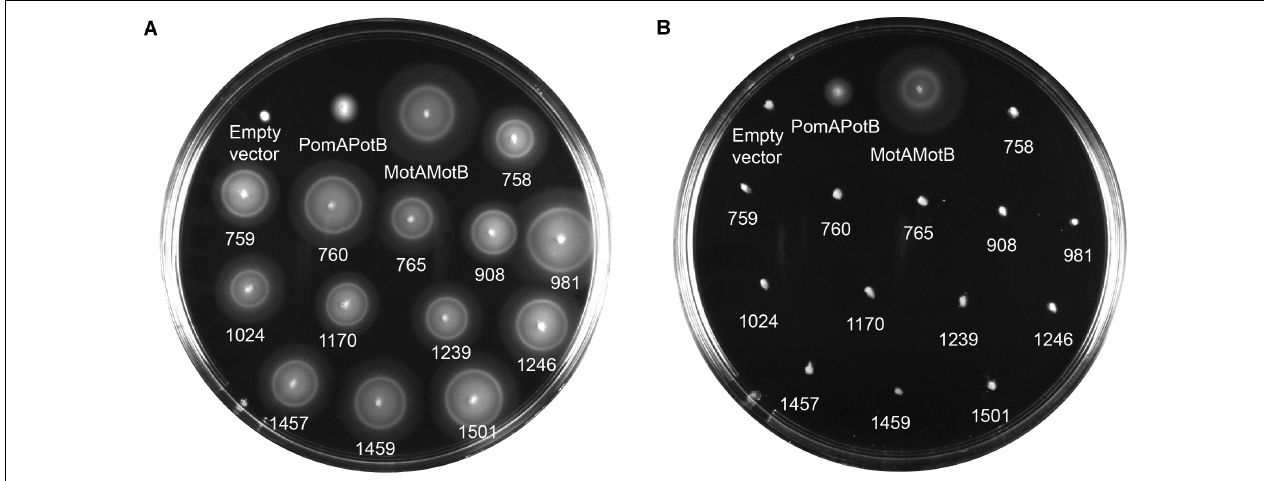
FIGURE 3 | MotB-ASRs are functional. Motility of resurrected MotB-ASRs along with the control Na + swimmer (PomAPotB), H + swimmer (MotAMotB), and non-swimmer (empty vector: pBAD33) were tested on semi-solid agar swim plates (0.25% w/v agar). (A) All MotB-ASRs (presented according to the respective nodes) restore motility in the presence of PomA (from plasmid) and MotA (from genome) in (cid:49) motB E. coli strain RP3087. (B) None of the resurrected MotB-ASRs restore motility in presence of PomA without MotA in (cid:49) motAmotB E. coli strain RP6894. Plates were incubated at 30 ◦ C for 14 h.